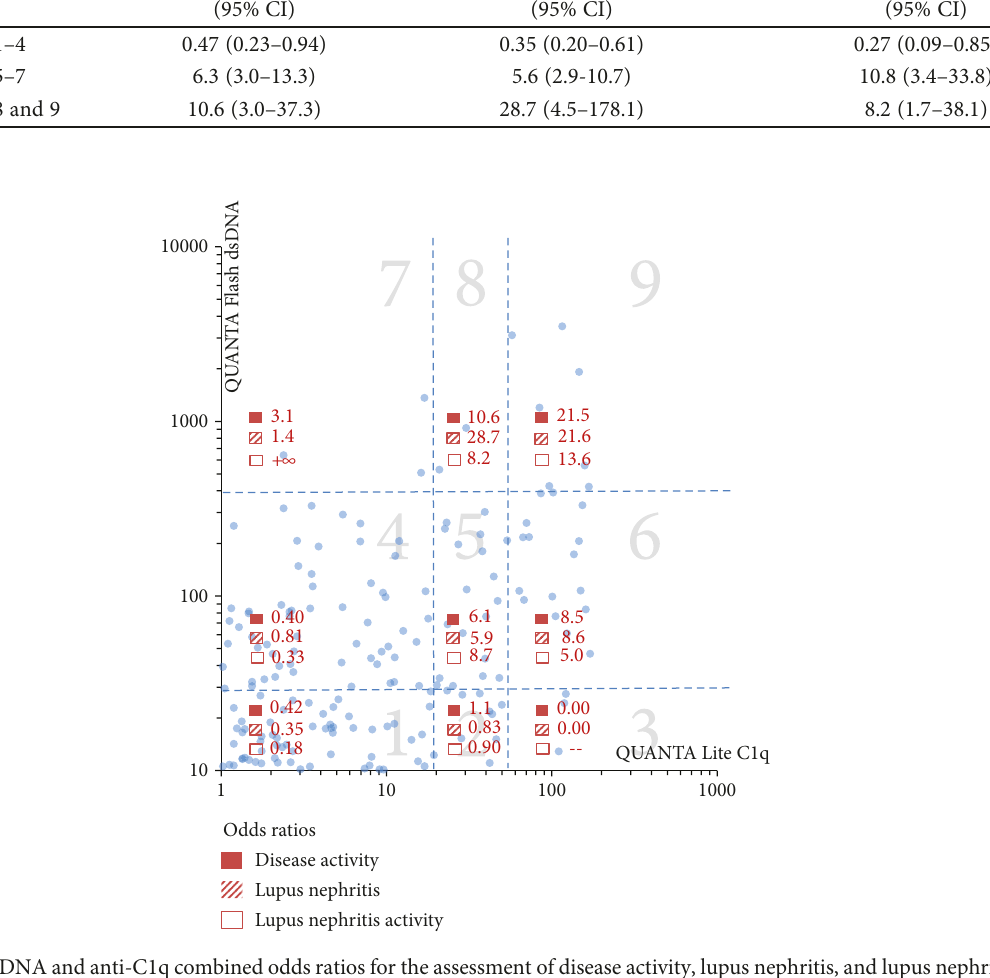
Table 2: Odds ratios (ORs) when combining anti-dsDNA and anti-C1q antibodies for the association with lupus nephritis (LN), LN activity and disease activity. Thresholds are based on clustering sections described in Figure 4.